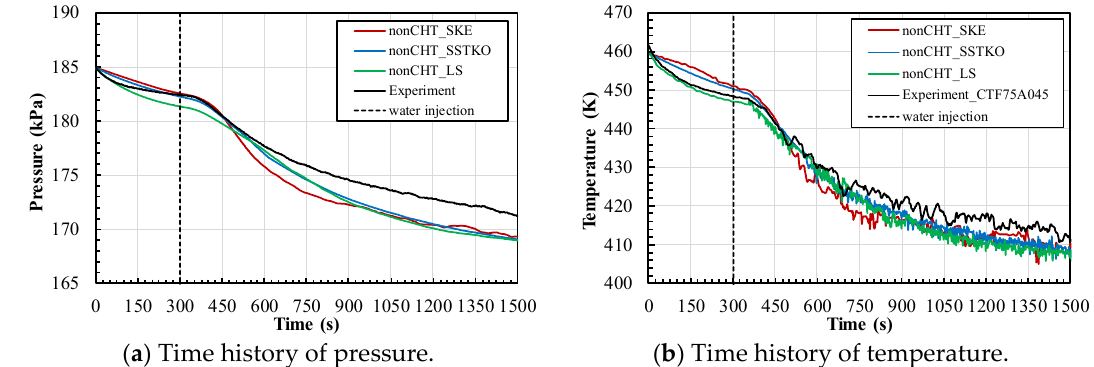
Figure 7. Comparison of the measured pressure and temperature (black lines) with the numerical CFD on the y + = 1 mesh (green line), medium mesh with the standard k - ε turbulence model (red lines), and medium mesh with the SST k - ω turbulence model (blue lines).